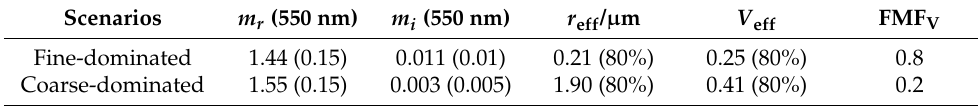
Table A2. The aerosol model parameters.